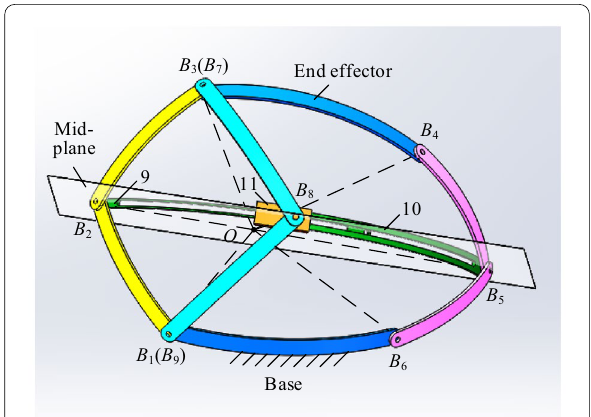
Figure 1 Schematic diagram of the 2-DOF